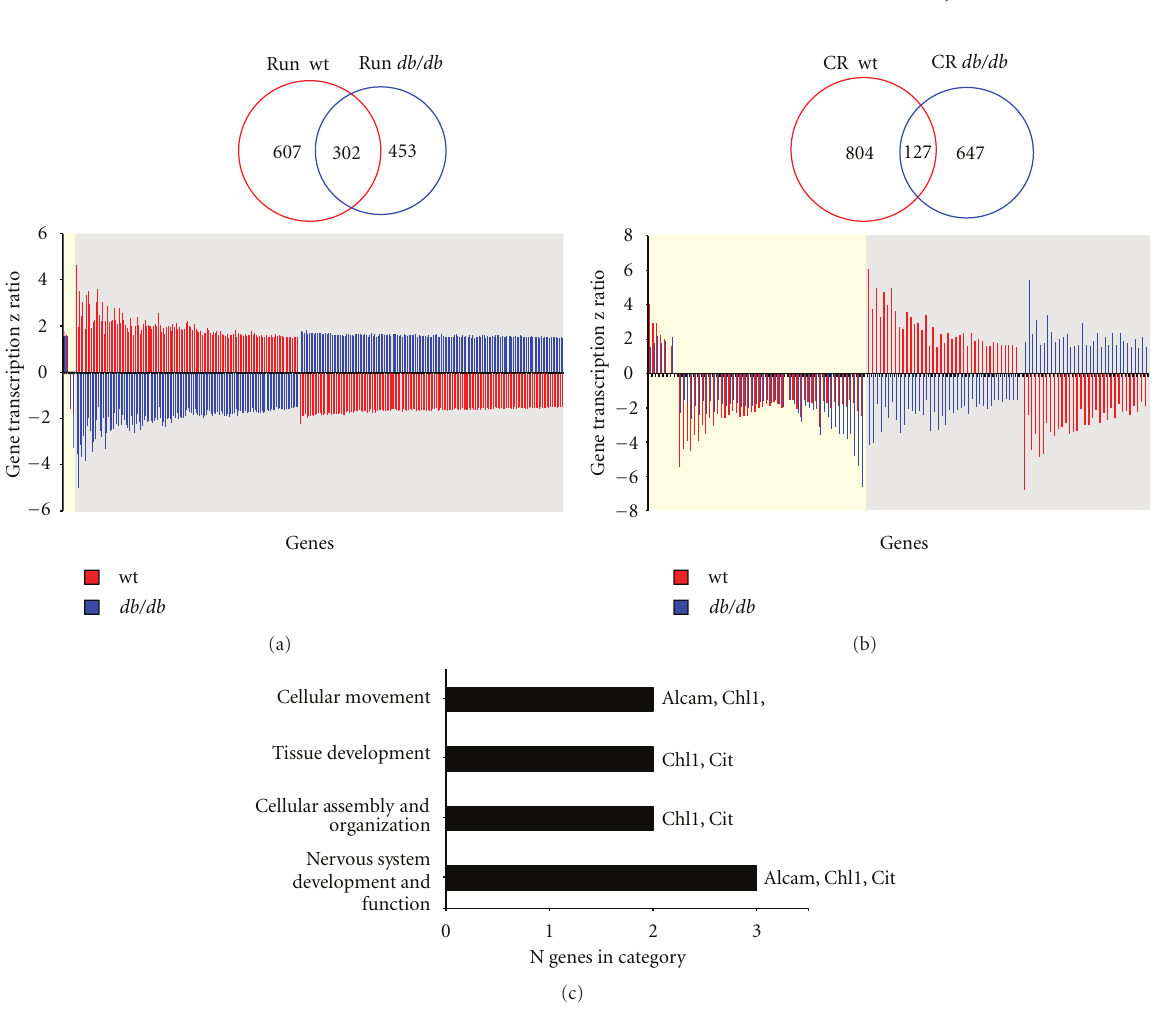
Figure 9: Physiological background di ff erentially modulates the e ff ects of exercise and caloric restriction upon hypothalamic transcriptomes. (a) Venn diagram illustrates the number of significantly regulated genes (up- and downregulated) a ff ected by exercise (Run) in WT (red) or db/db (blue) animals. The associated histogram indicates the significantly regulated genes common to the e ff ects of exercise in both genetic backgrounds (WT and db/db ). The yellow area indicates the genes whose direction of regulation was conserved in both genetic backgrounds while the grey area shows the genes that showed reversal of their exercise-mediated expression profile. (b) Venn diagram and associated histogram depict similar data to (a) but for the implementation of CR to the WT (blue) or db/db (red) mice. (c) Significantly regulated pathways associated with the conserved CR-induced transcriptional activity in both WT and db/db